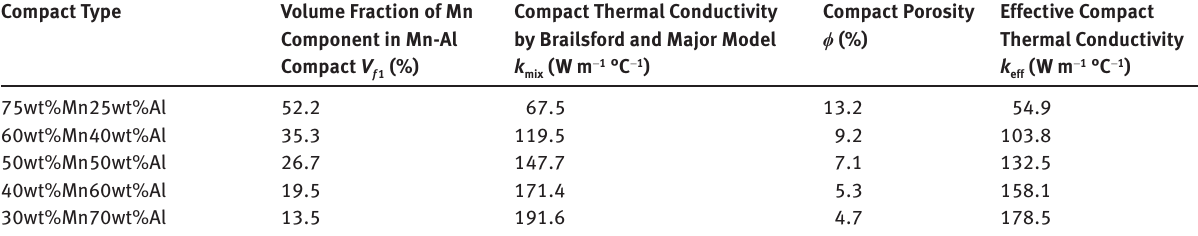
Table I-1: Effective thermal conductivities of various Mn-Al compacts calculated using Brailsford and Major model